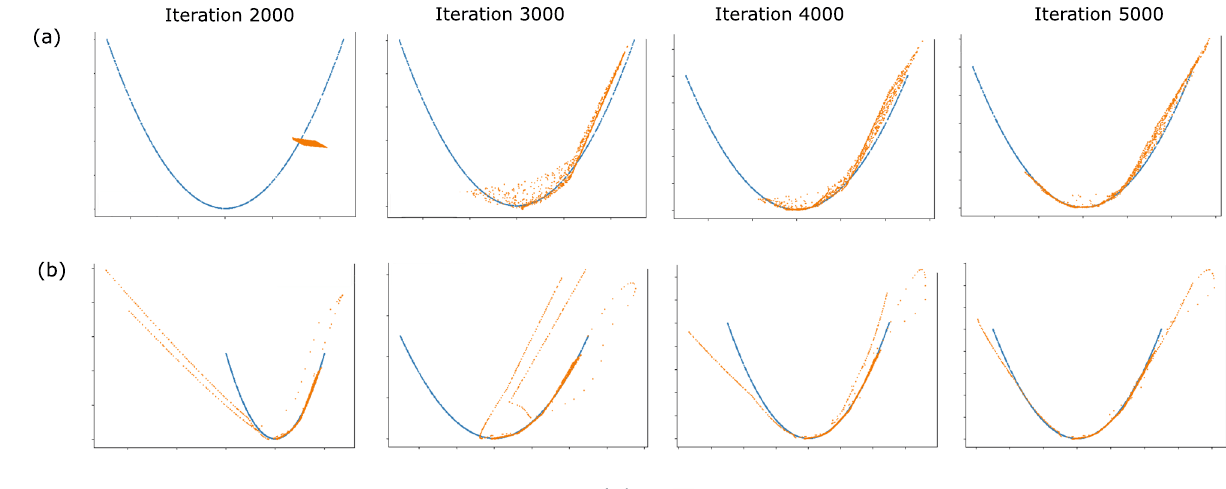
Fig. 2 A toy example demonstrating generation of a two dimensional data of known distribution. Results show the distribution of generated data and real data for traditional GAN (upper row, a ) and LSH-GAN (lower row, b ).